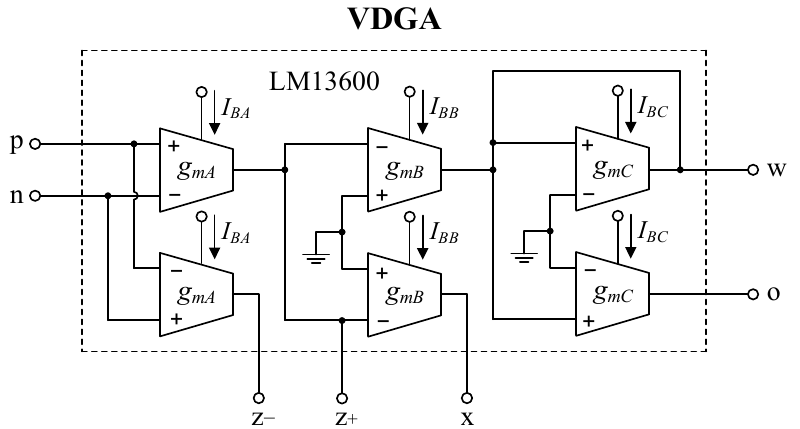
Figure 12. VDGA realization in experimental measurements using off-the-shelf available IC-type LM13600s.